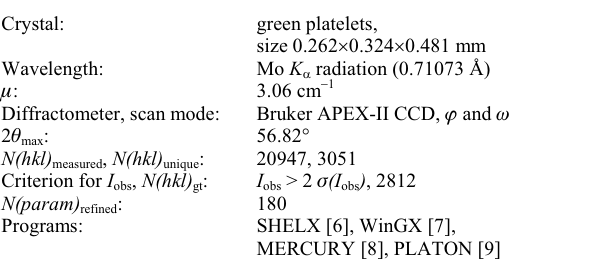
Table 1. Data collection and